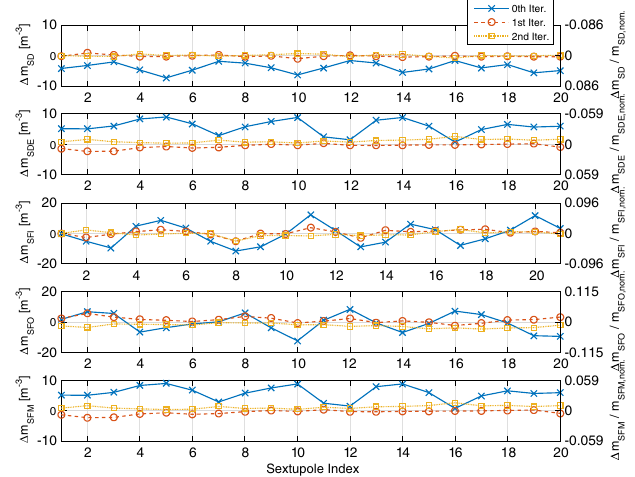
FIG. 12. Difference in sextupole strength from nominal iden- tified from the measured OEORM in each iteration. The changes of the SDend and SFm families are the same since the circuits have been combined when fitting.